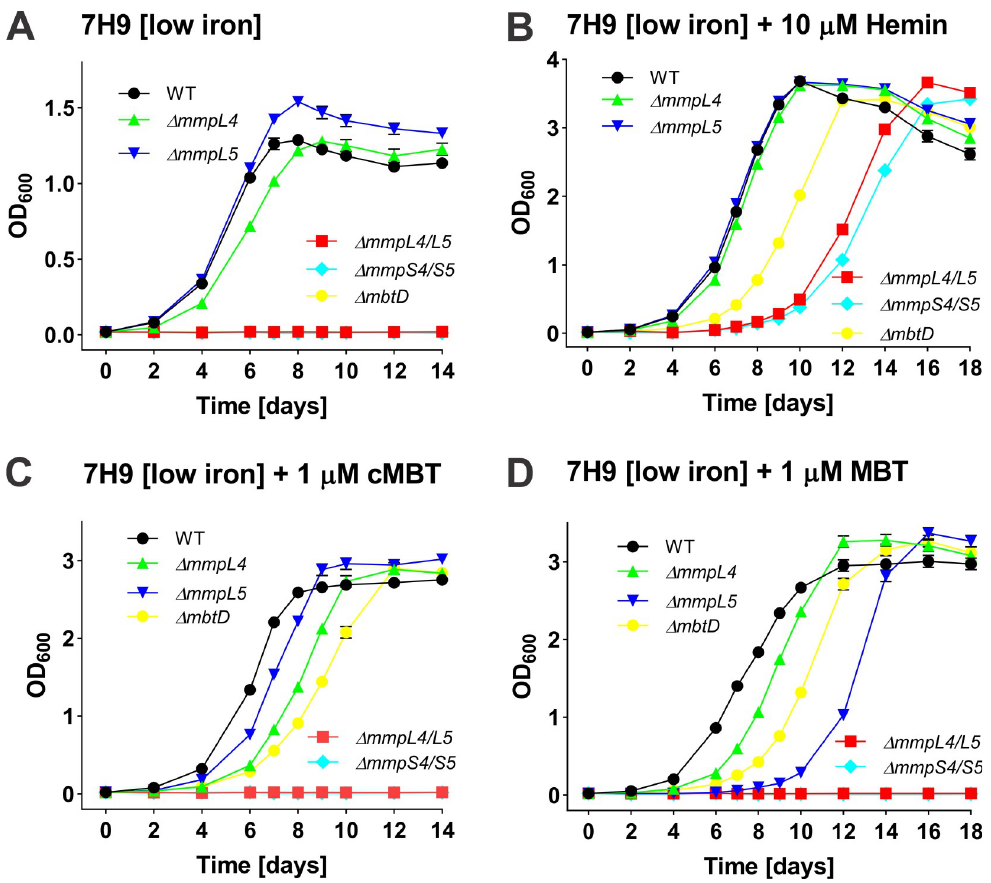
Fig 7. Growth of the M . tuberculosis mmpL4 and mmpL5 mutants under different iron conditions. Growth curves of Mtb strains including Mtb mc 2 6230 (as WT), Δ mmpL4 (ML2300), Δ mmpL5 (ML2301), Δ mmpL4/L5 (ML2302), Δ mmpS4/ S5 (ML859) and Δ mbtD (ML1600) in low-iron 7H9 medium (A) supplemented with 10 μ M hemin (B), 1 μ M carboxymycobactin (C) and 1 μ M mycobactin (D), respectively. The Mtb strains were grown in self-made low-iron 7H9 medium for 5–7 days to deplete intracellular iron before growth assays. The initial OD 600 of all the cultures is 0.01. Error bars represent standard deviations from the mean results of biological triplicates. zur ), and the fully complemented strain ML2280 (ML2277:: smtB-zur ) (S5 Fig, S1 Table). The parent Mtb mc 2 6206 strain, the fully complemented double mutant and the Mtb strain lacking only zur had no or only a minor growth defect in low iron or replete iron 7H9 medium, while the strain lacking smtB and the Δ smtB-zur double mutant had a general growth defect inde- pendent of the iron concentration as shown in Figs 8B and S6. Collectively, these results sug- gested that SmtB and Zur are not required for utilization of Fe 3+ ions. Growth of the strain lacking only zur was significantly reduced in the presence of 20 μ M hemin as the sole iron source in contrast to iron-replete or iron-deficient conditions, while the strain lacking SmtB had a similar growth defect compared to the parent strain in media with low iron and with hemin (Fig 8B and 8C and S6 Fig). These results indicated that Mtb requires Zur but not SmtB for hemin utilization. No growth of the Δ smtB-zur double mutant was observed in medium with hemoglobin as the sole iron sources (Fig 8D). Interestingly, only expression of both smtB and zur enhanced growth of the Δ smtB-zur double mutant, indicating that both regulators are essential for Mtb to grow with hemoglobin as the sole iron source (Fig 8D).